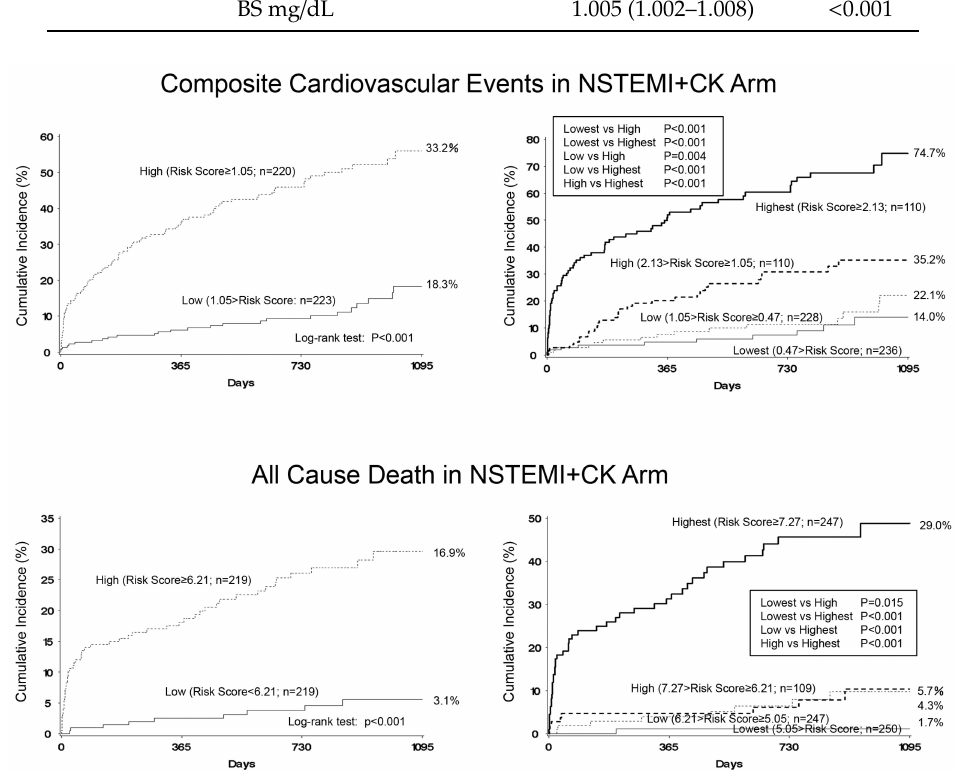
Figure2. Incidenceofcompositecardiovasculareventsandall-causedeathinpatientswithNSTEMI + CK. Two-group comparison based on the median values of risk scores (high or low) ( left ) and four-group comparison based on the quartile values of risk scores (highest, high, low, or lowest) ( right